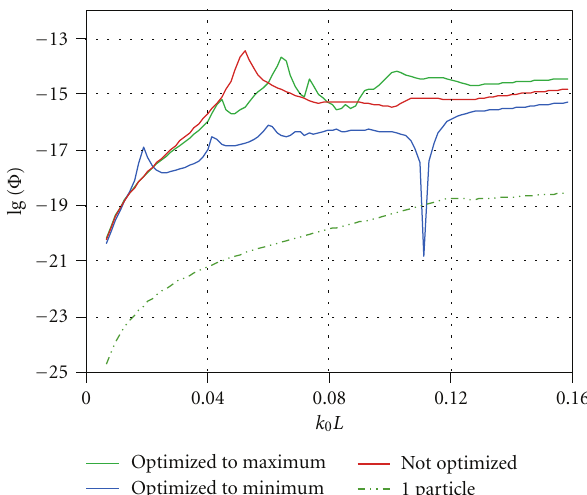
Figure 1: The logarithm of the reflectance Φ of the optimized Au cluster versus the normalized frequency k 0 L . The reflectance was optimized for the frequency k 0 L = 0 . 11 at the observation point r ob = { 0 . 87,0 . 5,0 . 00 } . The period of the cluster is d = 2 . 5 L and L = 10 nm. The green and the blue curves show the reflectance of the cluster optimized for maximal and minimal values, respectively. The red curve shows the reflectance of the nonoptimized cluster, and the green dash-dotted curve shows the reflectance of the single Au cube with the characteristic size L .